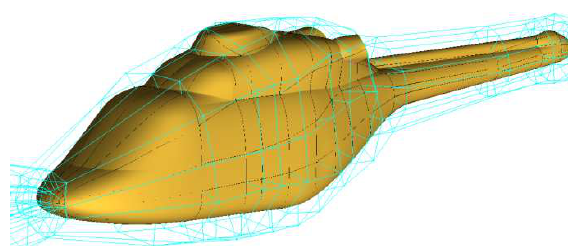
Fig. 7. Mesh topology near the fuselage .